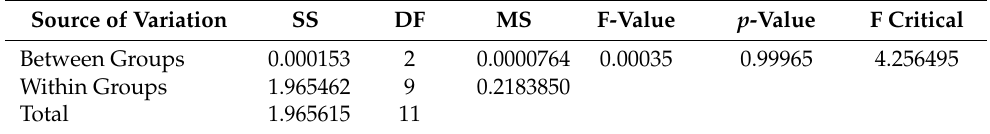
Table 10. ANOVA: Time Single Factor (NF). Source of Variation